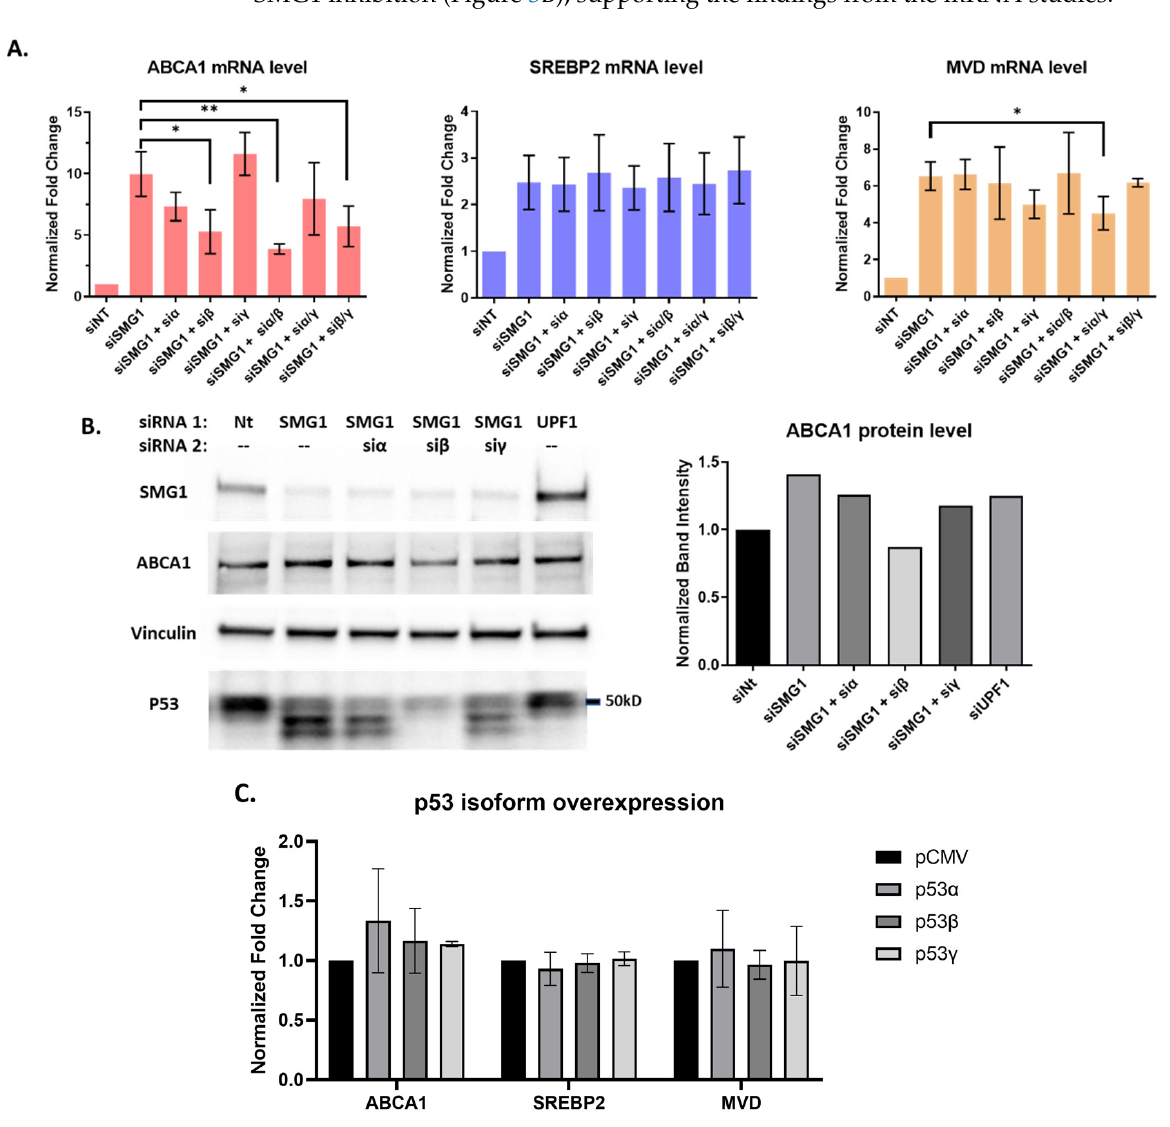
Figure 3. p53 isoforms differentially influence ABCA1 expression following SMG1 knockdown but are unrelated to SMG1 effects on MVA pathway. ( A ) Summary RT-PCR results from three experiments for ABCA1, SREBP2 and MVD mRNA expression from RNA collected from MCF7 cells 5 days after transfection with different siRNAs targeting SMG1 and SMG1 in combination with siRNAs targeting p53 α , p53 β , p53 γ or the combination of p53 α + p53 β , p53 α + p53 γ , and p53 β + p53 γ . non-target siRNA (siNT) is included as a control. ( B ) Representative Western blot results for ABCA1 protein showing MCF7 cells treated with the different combinations of siRNAs as in panel A harvested 5 days post-transfection. The DO-1 (aa 20–25) p53 specific antibody was used examine alternative splicing. The bar plot on the right shows band intensity of ABCA1 normalized by the vinculin band intensity as a loading control. ( C ) Summary RT-PCR results from three independent experiments for ABCA1, SREBP2 , and MVD mRNA expression from RNA collected from MCF7 that were harvested 2 days post-transfection with p53 isoform plasmids and compared to pCMV vector control. p -values shown for siSMG1 versus the different combinations of siSMG1 and p53 isoform siRNA(s) are from unpaired t-test. * = p < 0.05; ** p < 0.01. Error bars represent Mean ± SD. For all RT-PCR studies, individual samples are run in triplicate. Original Western blots, view Supplemental